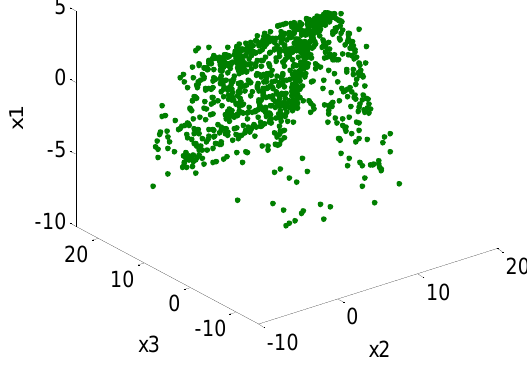
Figure 1. Strange attractor of hyperchaotic system.